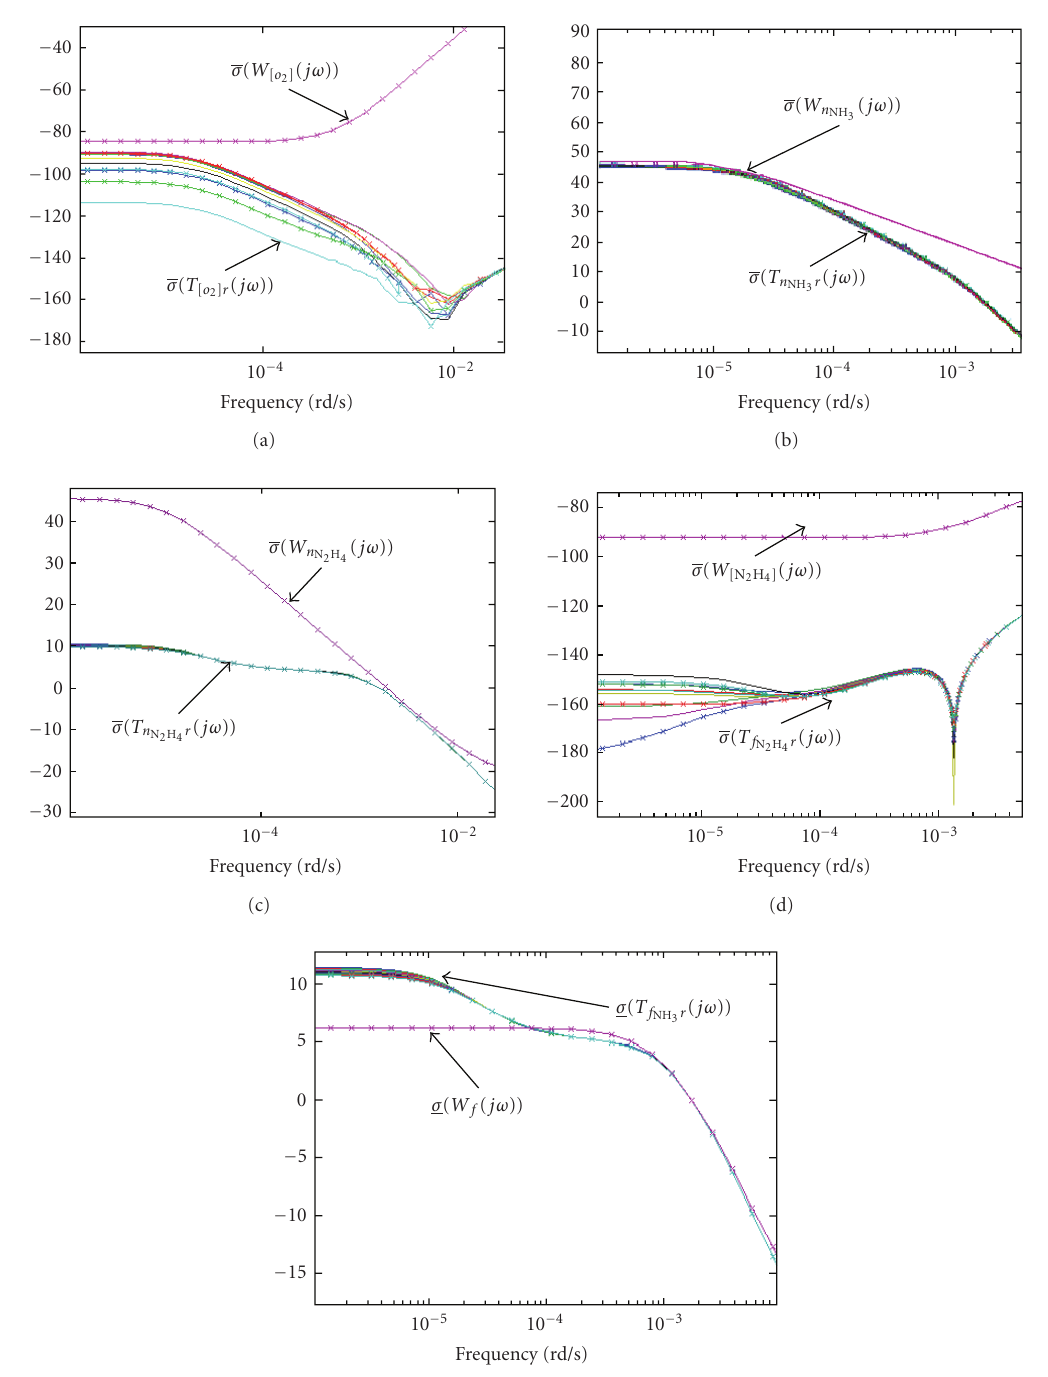
Figure 7: Behavior of the principal gains of the closed loop transfers T k